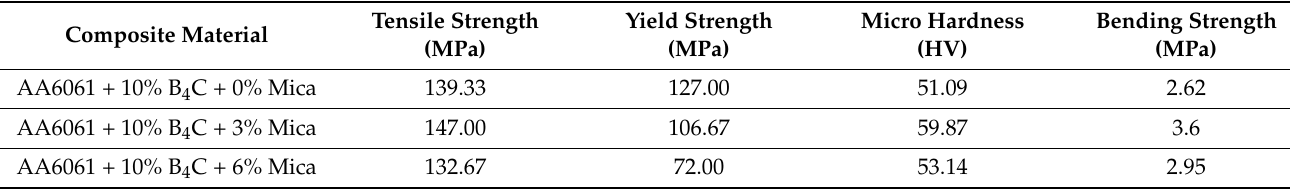
Table 1. Material properties of the composite materials